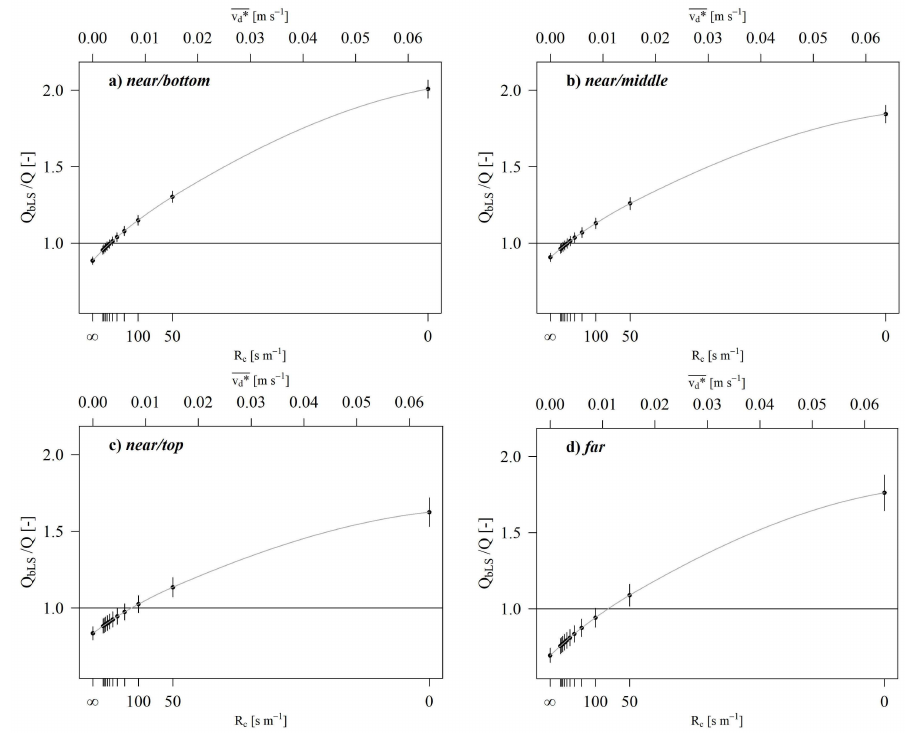
Figure 7. Sensitivity of the Q bLS / Q ratio to the canopy resistance R c and the average of the corresponding surface deposition velocities v ∗ (secondary x-axis on top). Points and vertical lines d indicate the average Q bLS / Q over all intervals with the associated 95% confidence intervals. The line shows the local polynomial regression